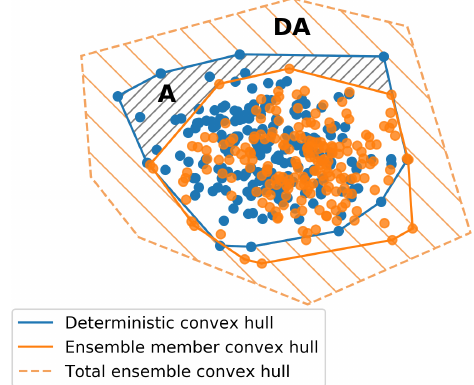
Figure 5. Schematic of convex hull areas (blue and orange solid outer lines) for the deterministic oil spill particles and an individual member of the ensemble (blue and orange dots). The orange dashed outer line shows the convex hull of the whole ensemble including all members. The orange hatched area DA shows the difference be- tween the whole ensemble convex hull exceeding the deterministic convex hull. The gray hatched area A shows the difference between the deterministic convex hull exceeding the convex hull of an indi- vidual member selected from the